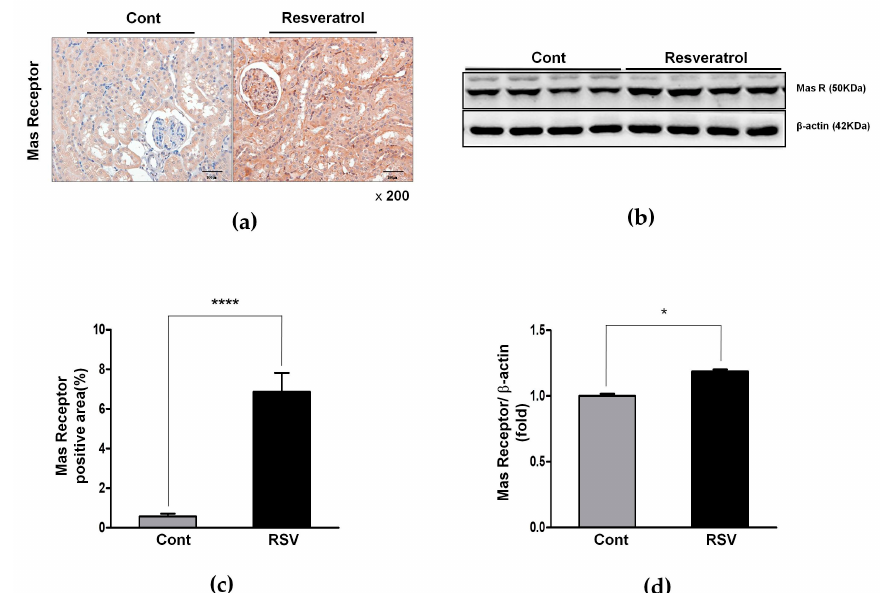
Figure 8. Effects of resveratrol on MasR. ( a ) Representative images of immunohistochemical staining of MasR in the aging kidney glomerulus (original magnification 200×). ( b ) Representative western blots of MasR. ( c ) MasR-positive area in the kidney was significantly increased in the RSV group. ( d ) The expression of MasR was significantly increased in the RSV group (* p < 0.05, **** p < 0.0001).